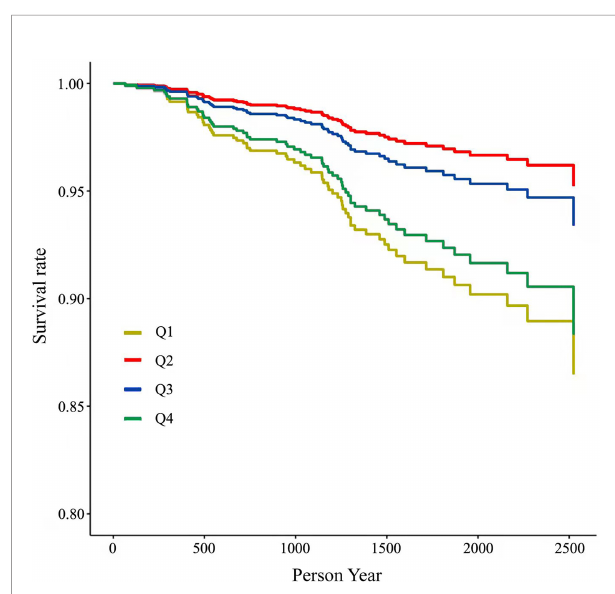
FIGURE 2 | Multivariate-adjusted cumulative survival curves of all-cause mortality by different levels of 25-OH vitamin D levels. Adjusted for age, sex, insurance status, smoking, and alcohol drinking.